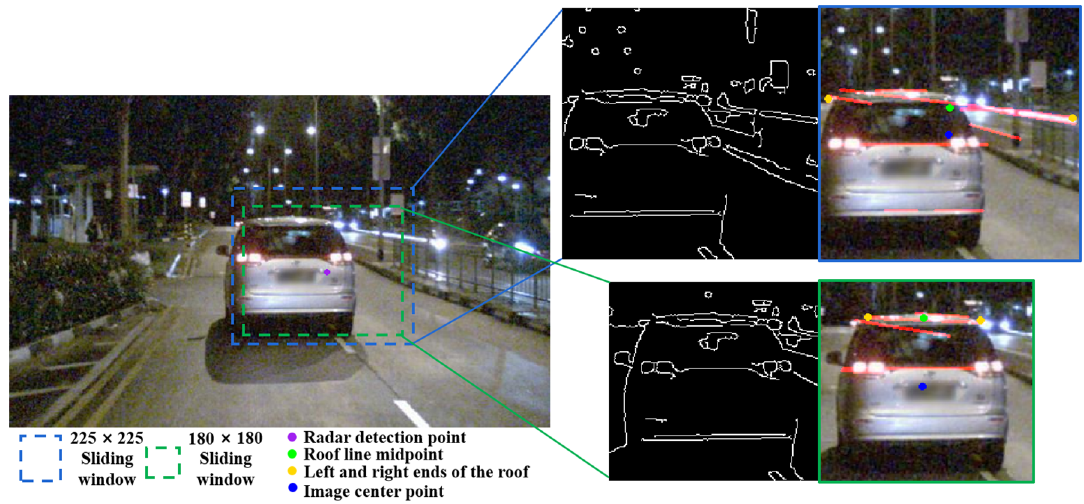
Figure 16. Detection of sliding windows of different sizes in night scenes.